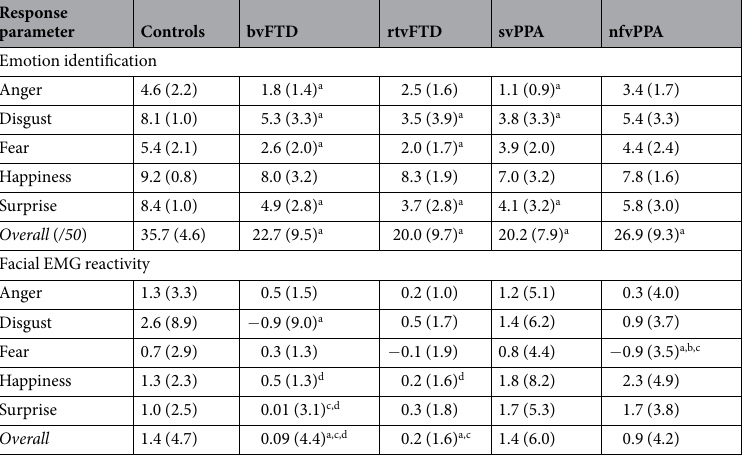
Table 2. Summary of emotion identification and EMG reactivity findings for participant groups Mean (standard deviation) scores on the emotion identification task and mean facial EMG reactivity (as defined in Fig. 1) to viewed emotional expressions are shown for each emotion, in each participant group. a significantly less than healthy controls, b significantly less than bvFTD, c significantly less than svPPA, d significantly less than nfvPPA (all p bonf < 0.05). bvFTD, patient group with behavioural variant frontotemporal dementia (excluding right temporal cases); Controls, healthy control group; nfvPPA, patient group with nonfluent variant primary progressive aphasia; rtvFTD, patient subgroup with right temporal variant frontotemporal dementia; svPPA, patient group with semantic variant primary progressive